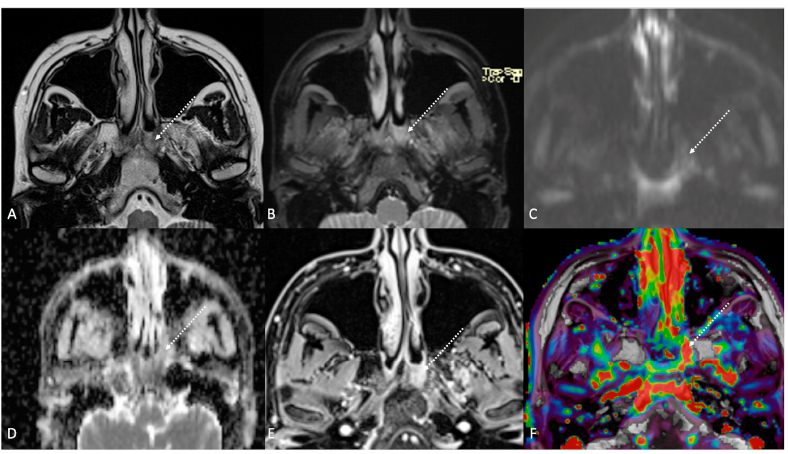
Figure 4. Post-treatment magnetic resonance imaging (MRI) of a 36-year-old female patient affected by nasopharyngeal carcinoma with left lymph node metastasis (T3N3) and tumoral extension to bilateral Ronsemüller fossa, left nasal choana, and middle skull base, recently treated (3 months before) with chemoradiotherapy (CRT). Early post-treatment MRI demonstrated post-CRT inflam- matory residual tissue (white striped arrows) in the left Ronsemüller fossa and ipsilateral nasal choana. Post-CRT inflammatory changes showed hyperintense signal on T2-weighted ( A ), T2-weighted fat-saturated ( B ), and diffusion-weighted b800 images ( C ); high apparent diffusion coefficient value (1.53 × 10 − 3 mm 2 /s) ( D ). After gadolinium contrast agent injection, post-CRT inflammatory residual tissue shows submucosal enhancement of 5 mm thickness ( E ), and very high K(trans) value (595.25 × 10 − 3 mm 2 /s) on dynamic contrast enhancement-perfusion weighted imaging ( F ). Ratio between K(trans) values of the primitive tumor and residual tissue after CRT, standardized with respect to K(trans) value of the ipsilateral trapezius (K(trans)post/pre/muscle), was 3.17. These findings suggested an increase in capillary permeability caused by CRT.